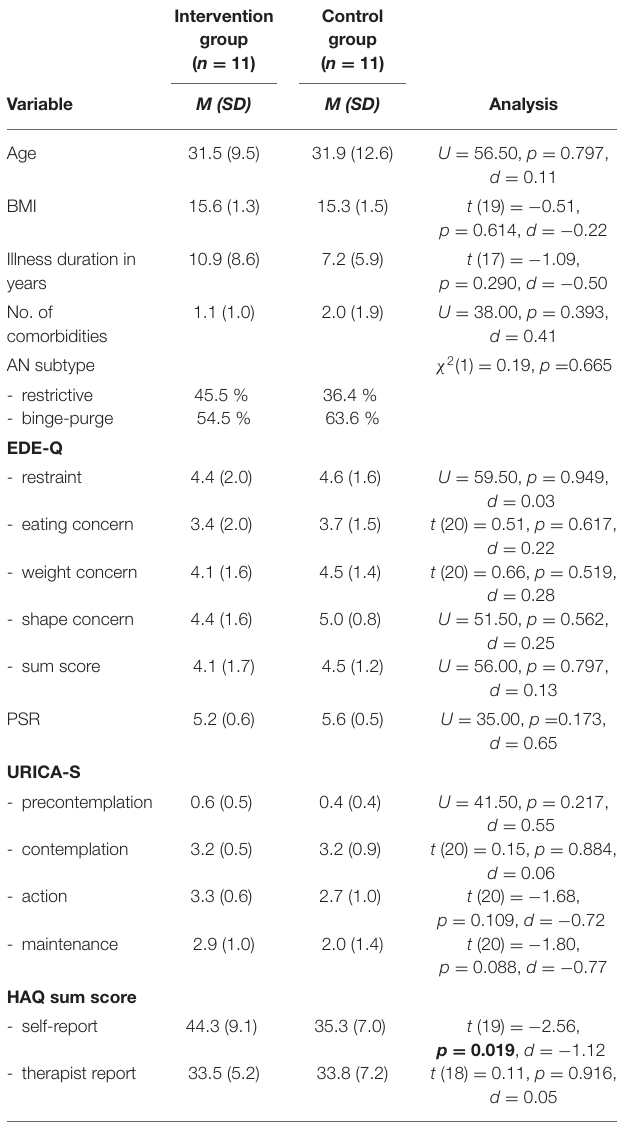
TABLE 1 | Demographic and clinical characteristics of the study population at baseline ( N = 22). Intervention